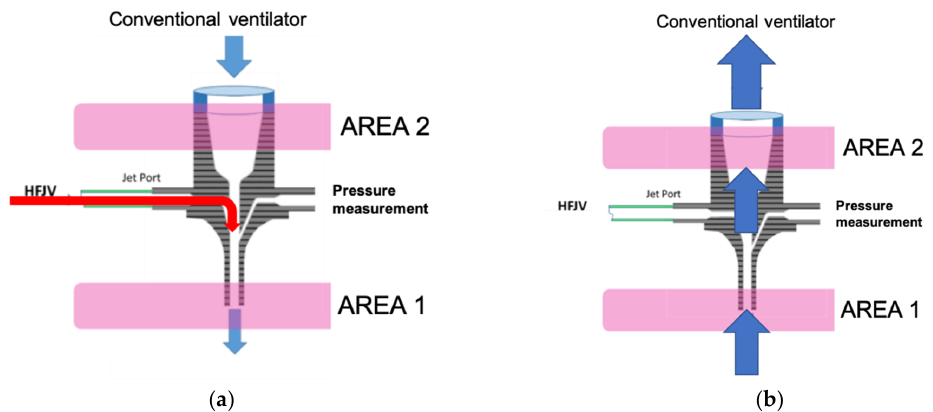
Figure 1. Visualization of Life Port: ( a ) The course of gas inspiration; ( b ) Exhalation on the right. There are theoretically two measurement options: